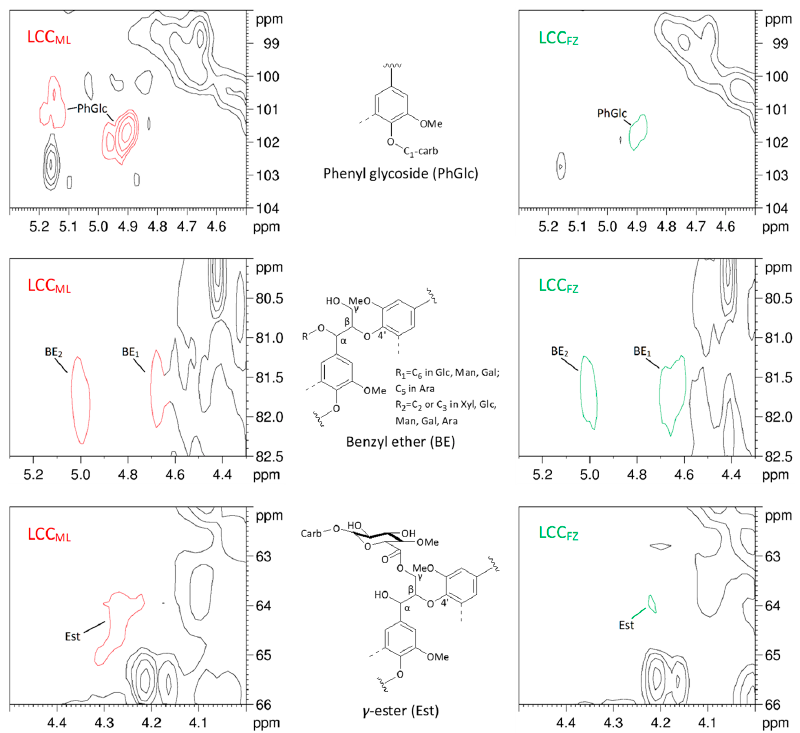
Figure 6. Partially amplified signals, PhGlc ( δ C / δ H 104–98/5.3–4.5), BE ( δ C / δ H 82.5–80/5.3–4.3), and Est ( δ C / δ H 66–62/4.5–4.0), of LCC ML and LCC FZ in the HSQC NMR spectra and the structure of the main LCC linkages.